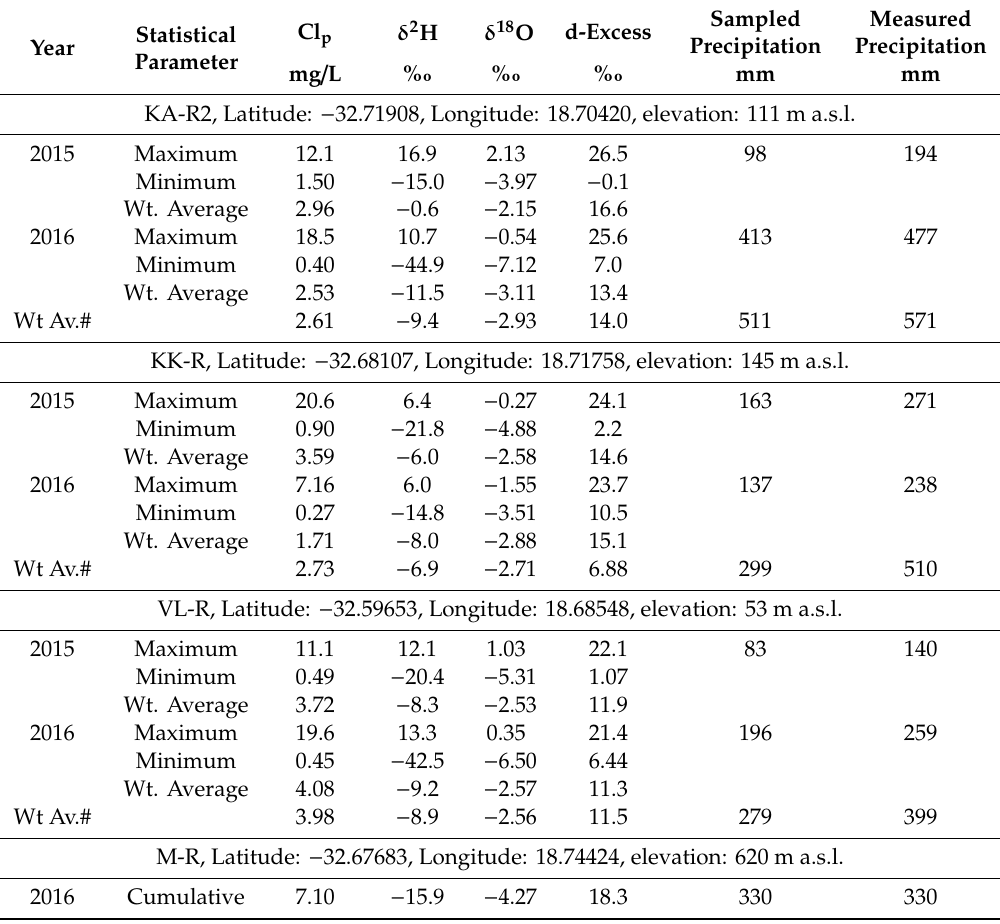
Table 1. Summary of chloride concentration, stable isotopes and precipitation amounts at